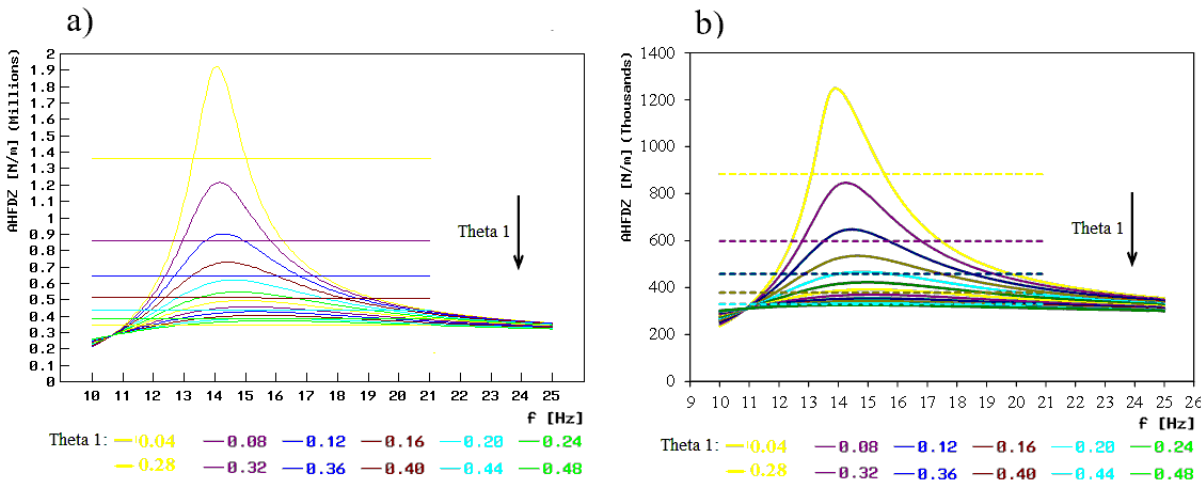
Figure 4: Factors of gain (AHFDZ) in the vertical force at the tire-exciter contact point (relative to the input force) close to the second natural frequency of the front “quarter car” for various damping values ϑ 1 (Theta1): the horizontal lines represent the values of AHFDZ max / a) results for the linear model; b) results for the nonlinear